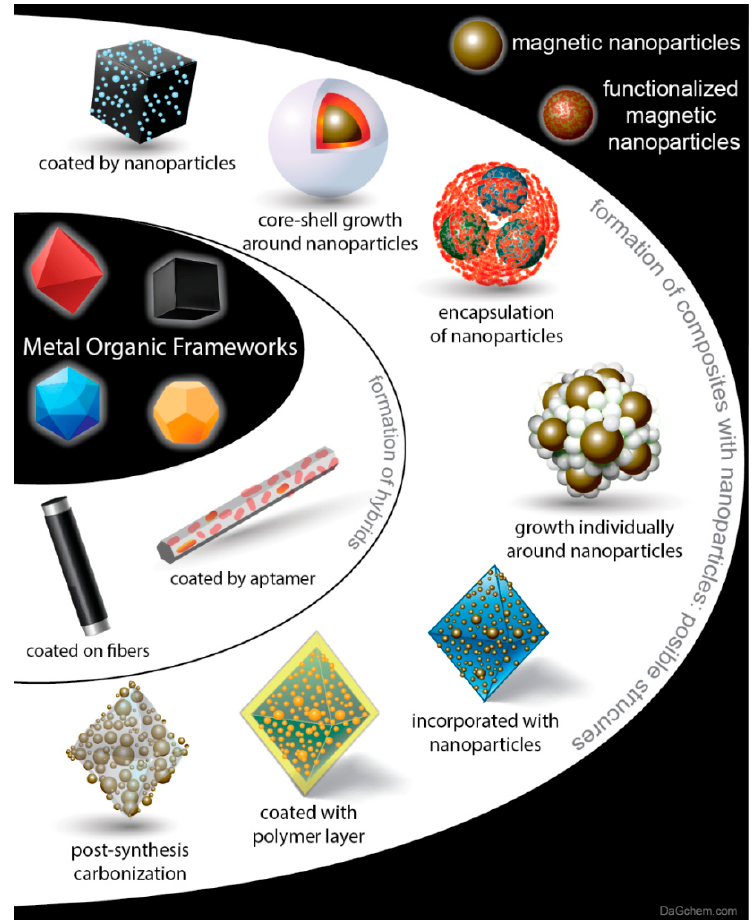
Figure 1. Different approaches for the formation of composite/hybrids as potential medias for the extraction, detection, or sensing of organic and inorganic pollutants from fish samples.